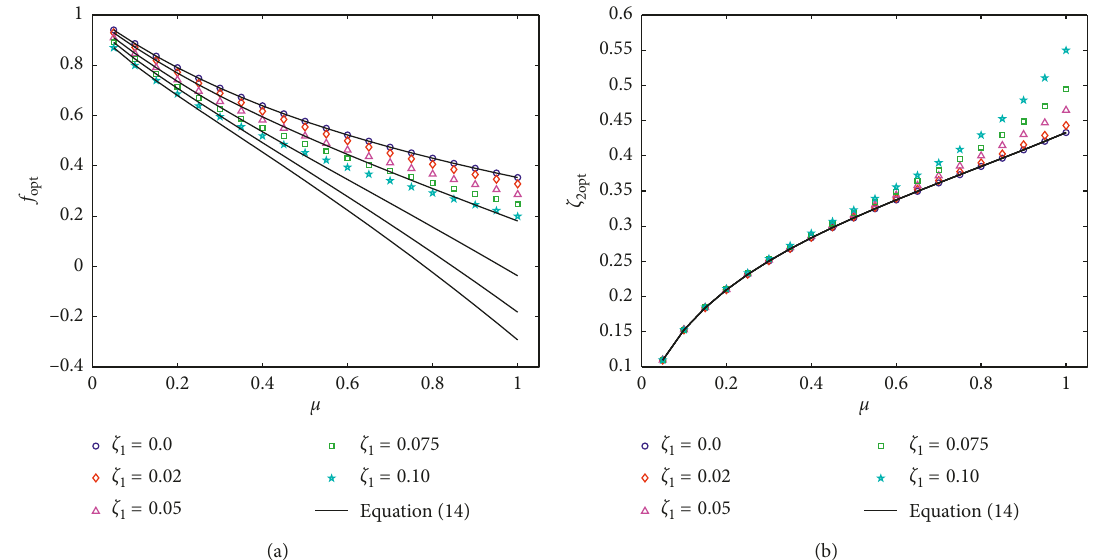
Figure 6: The curve of the calculated value of the existing fitting formula and the actual optimal value varies with the mass ratio under stationary white noise excitations. (a) Contrast results of the frequency ratio. (b) Contrast results of the damping